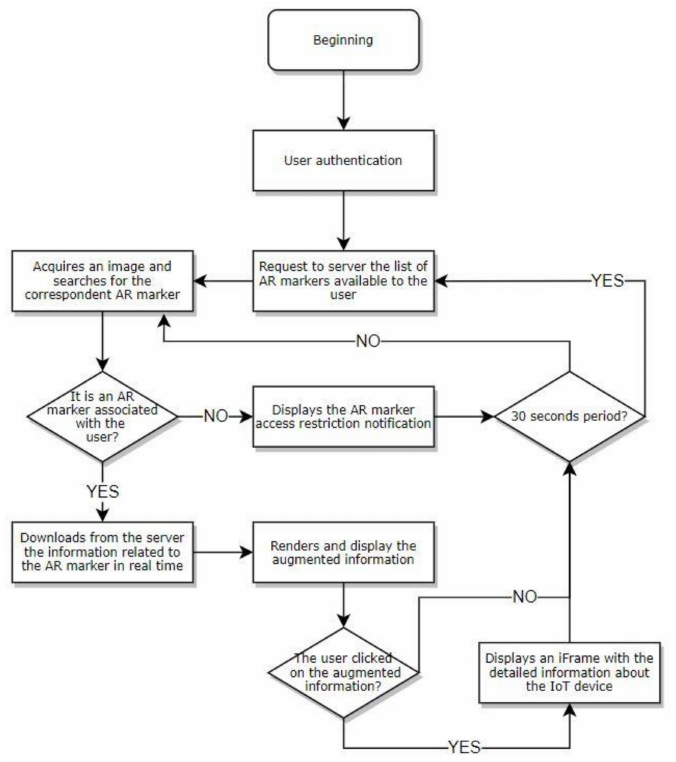
Figure 13. Process view of the client’s